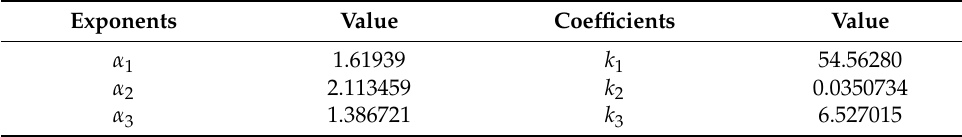
Table 6. Modified Coef. and Exp. of Bertotti Method.